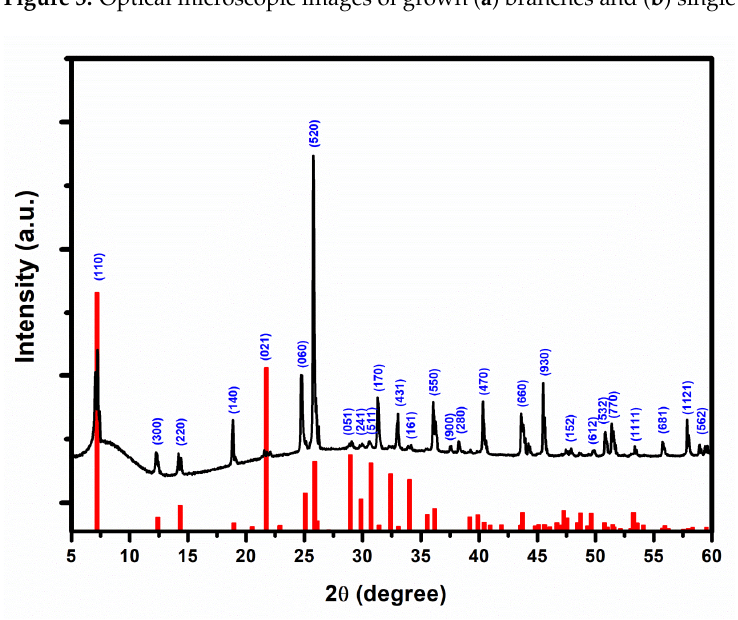
Figure 4. X-ray diffraction (XRD) pattern of prepared SbI 3 •3S 8 crystal. (The peaks are marked with crystal planes and below provide the JCPDS (PDF No. 71-2024) of SbI 3 •3S 8 crystal.) Table 1. Comparison of a diffraction angle (2 T ) from the results obtained from the XRD experiment with standard values for the SbI 3 · 3S 8